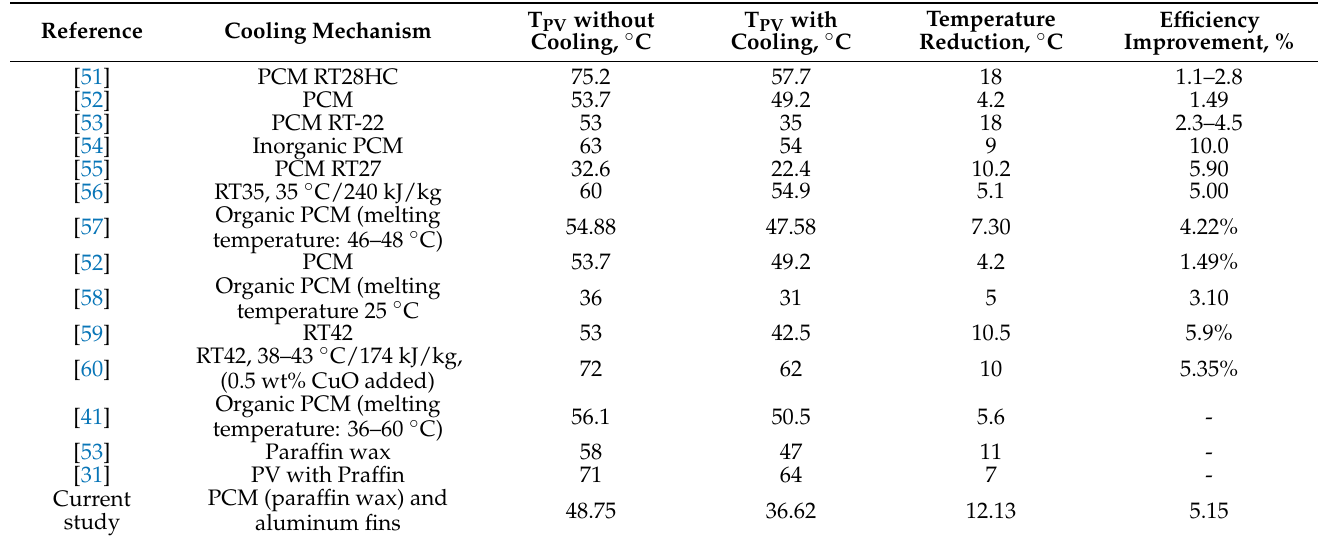
Figure 11. ( a ) Efficiency ( b ) improvement of the two modules with time. Table 2. Comparison with other